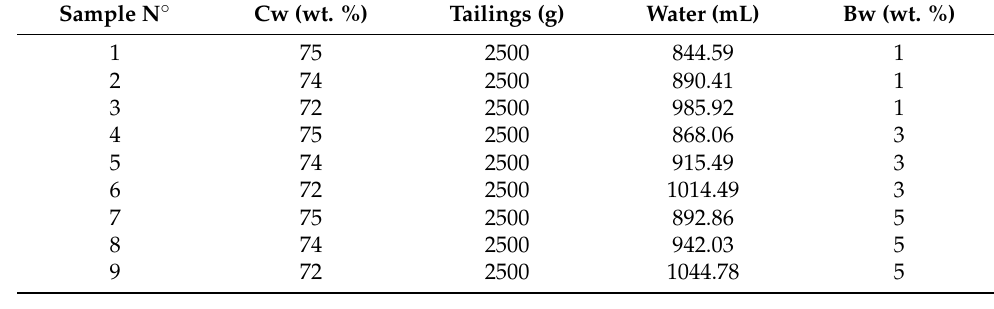
Table 3. CWTB mixtures recipes at different solids and binder contents.